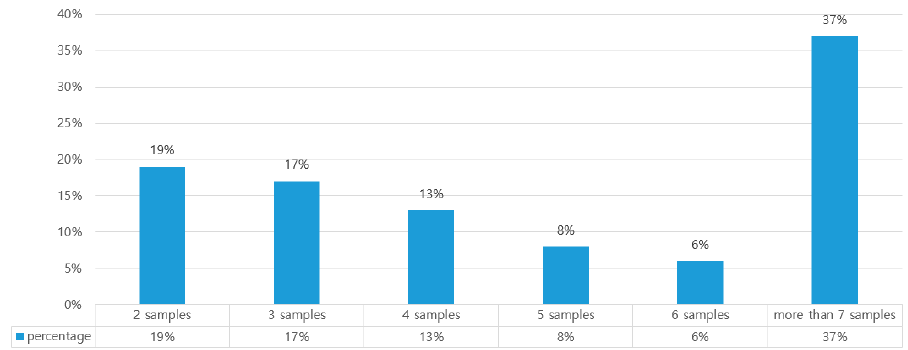
Figure 5. Distribution of the number of queries over the full FAQ categories.